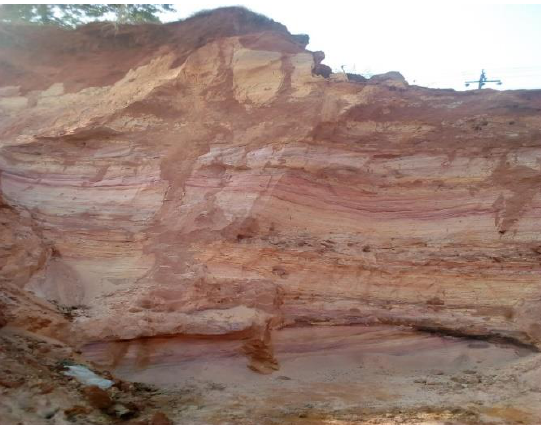
Figure 6: Exposed Soil Profile on the Excavated